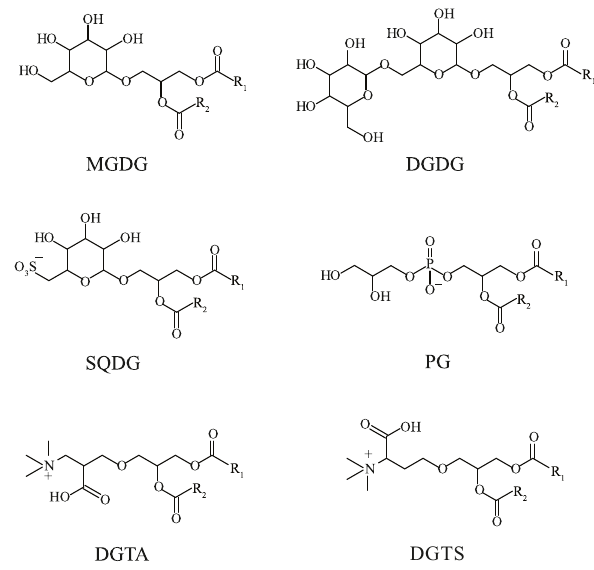
Figure 1. Structures of the detected IPL classes in Micromonas pusilla : the glycolipids monogalactosyldiacylglycerol (MGDG), di- galactosyldiacylglycerol (DGDG), and sulfoquinovosyldiacylglyc- erol (SQDG); the phospholipid phosphatidylglycerol (PG); and the betaine lipids diacylglyceryl-(N, N, N)-trimethylhomoserine (DGTS) and diacylglyceryl hydroxymethyltrimethyl- β -alanine (DGTA). R1 and R2 represent the acyl